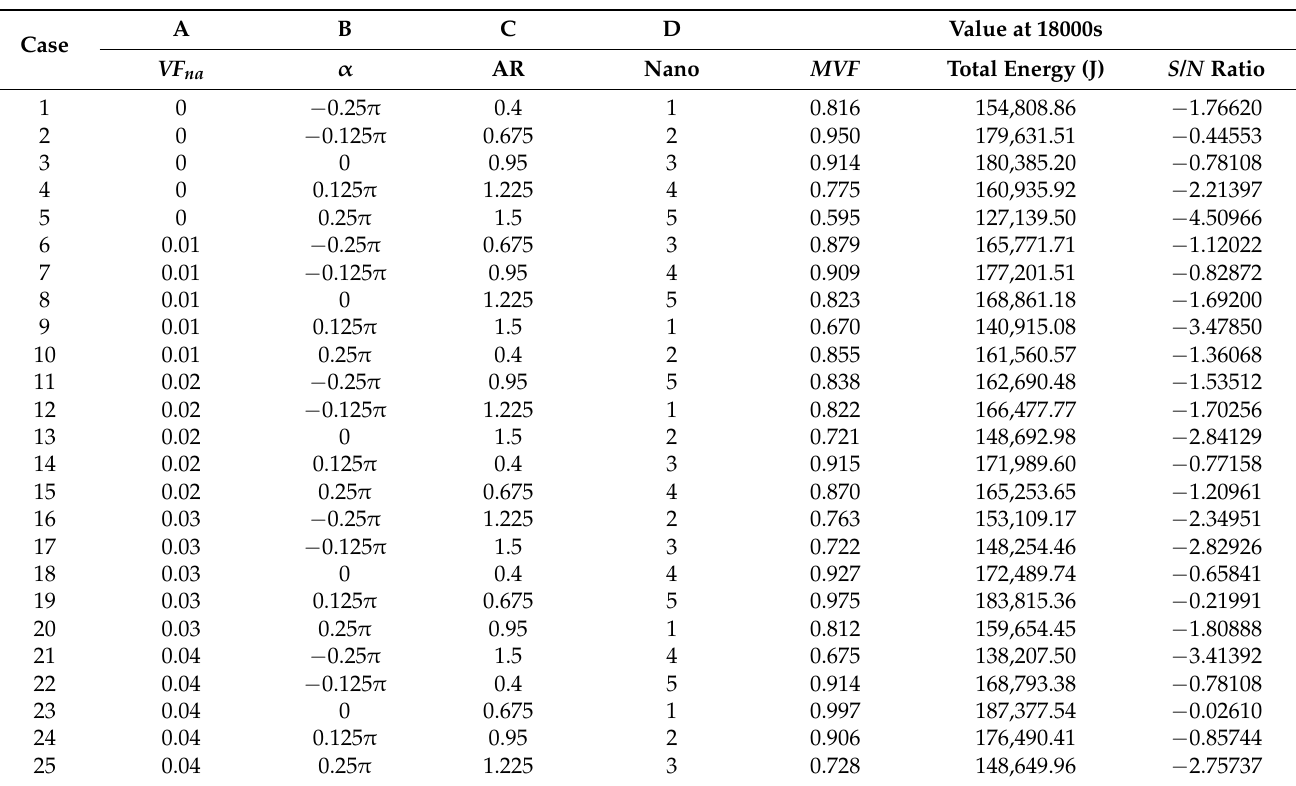
Table 5. The L25 Taguchi table for four design variables and five levels.